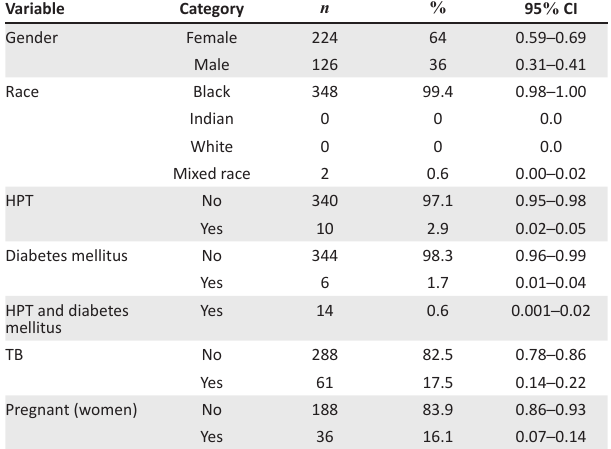
TABLE 4: Baseline demographics of the 350 patients included in the analyses. Variable